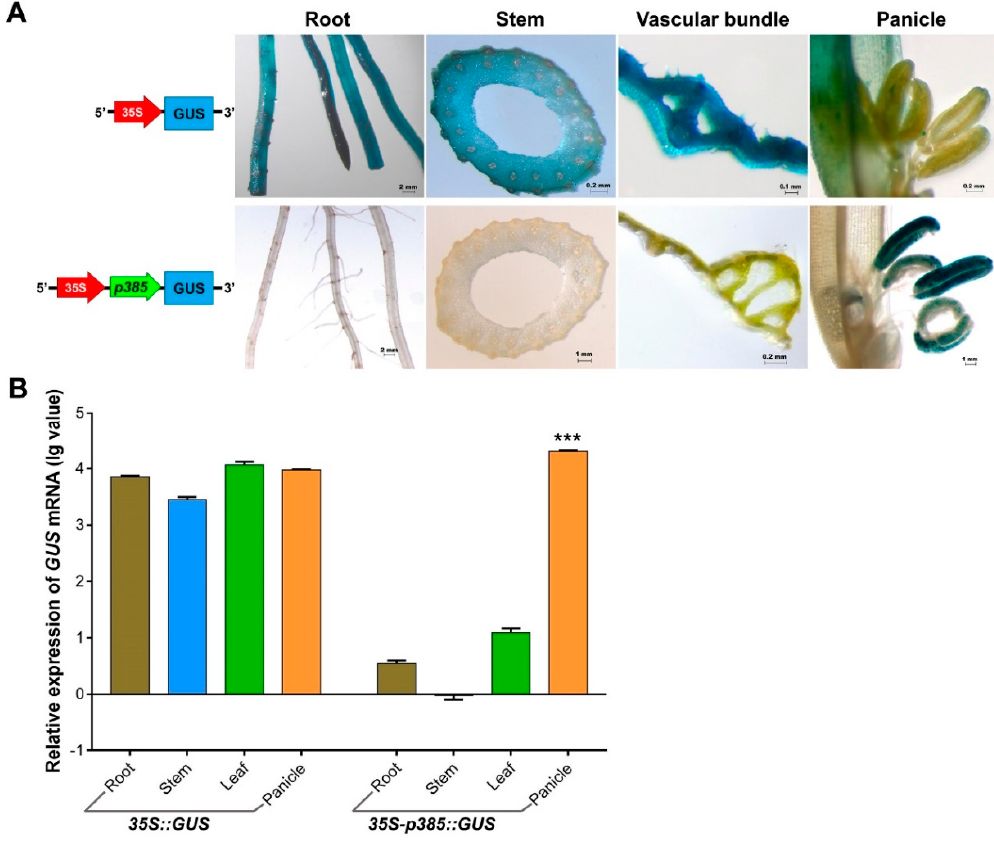
Figure 5. GUS expression in various rice transformants as contrasted with non-carrier plants. ( A ) Histochemical analysis of GUS expression in di ff erent tissues from non-carrier and transgenic rice plants harboring 35S-p385:: GUS and p385:: GUS constructs. Linear maps for transgenic rice are located on the corresponding left of stained tissues. ( B ) Quantitative qRT-PCR analysis of GUS transcripts from the root, stem, leaf, and panicle of non-carrier plant and transgenic rice plants harboring 35S-p385:: GUS and p385:: GUS constructs. Brown bar chart: root; blue bar chart: stem; green bar chart: leaf; orange bar chart: panicle. Data are shown as mean ± SD ( n = 3), student’s t -test. *** indicates highly significant di ff erences from all tested tissues for each transgenic plant. Relative expression was calculated as: lg2 − ∆∆ Ct .